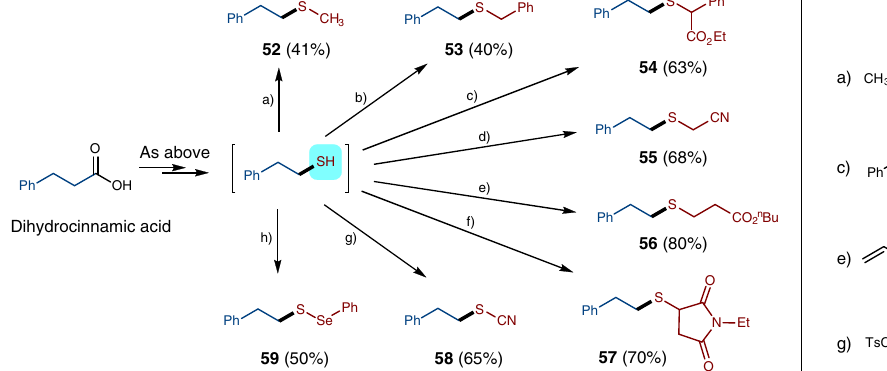
Fig. 3 Reaction extension and product diversi fi cation. a Extension to disul fi de synthesis. b In situ diversi fi